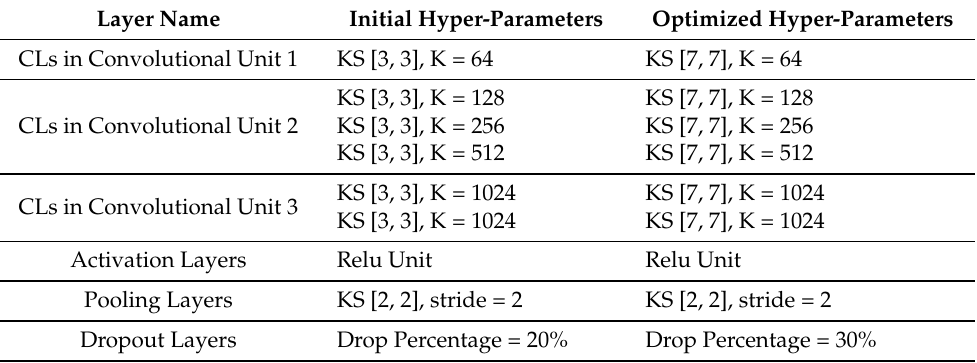
Table 2. Hyper-parameters setting for our proposed DCRN